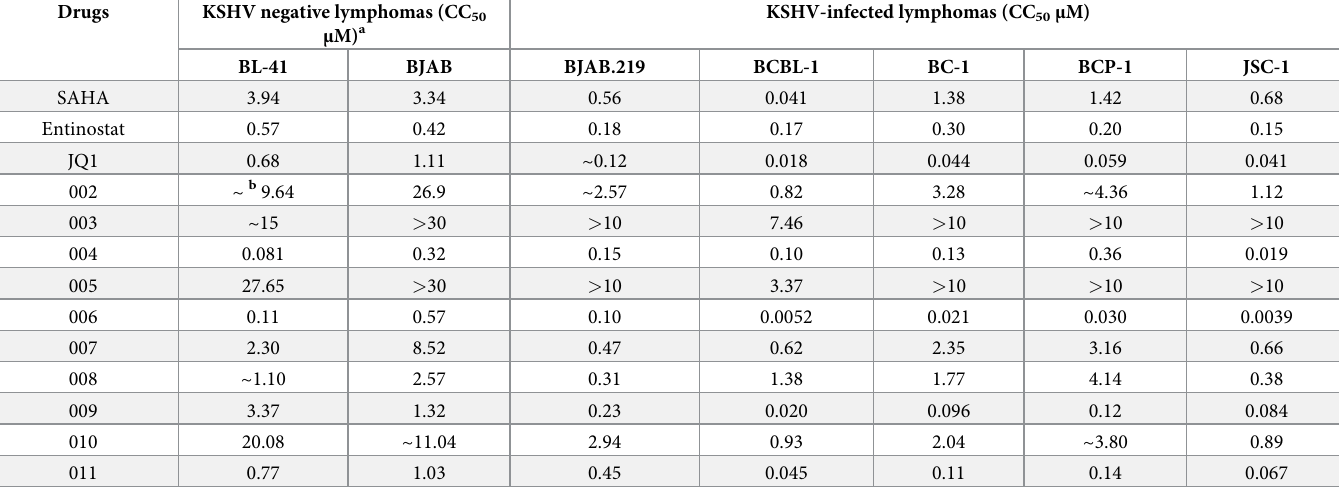
Table 1. Screening of Anti-KSHV+ lymphoma activities of newly synthesized HDACs/BRD4 dual inhibitors.